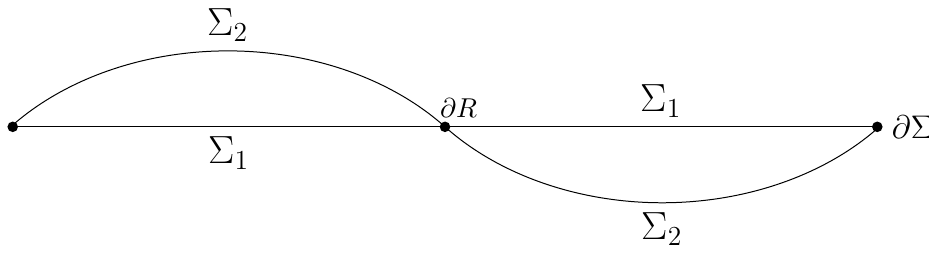
Figure 4 . The third case, in which Σ 2 straddles Σ 1 , is shown. We are using the convention that we fix the time orientation of M to always be upward so that the time-ordering of the two slices is opposite in the two